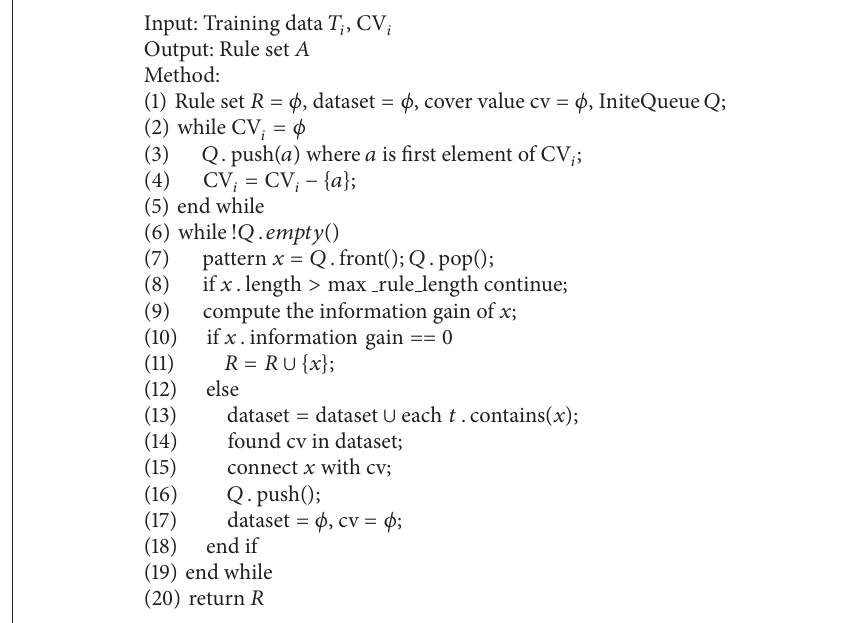
Algorithm 3. Step 3, CDCR recalculates the CV (cover